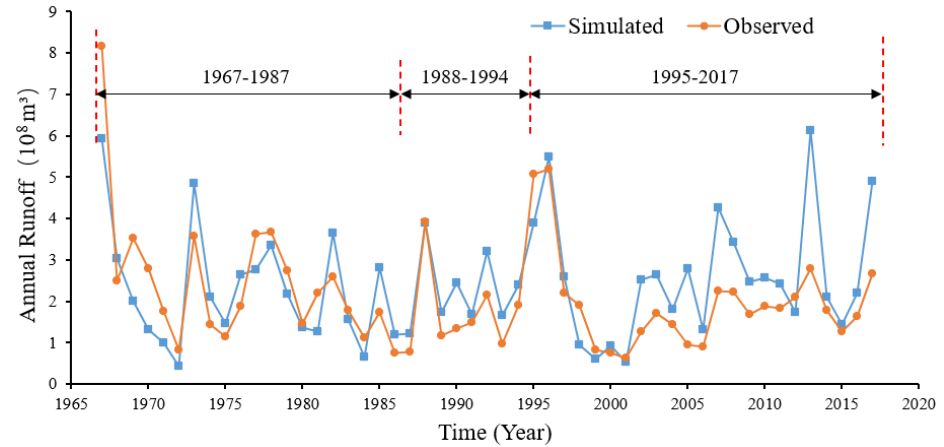
Figure 5. Observed and simulated using the SWAT model annual runoff series during the period of 1967--2017.